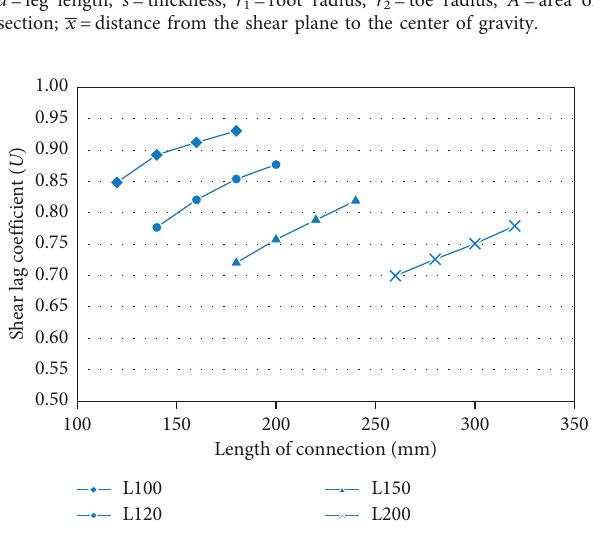
Figure 8: Effect of connection length on the tension capacity of single